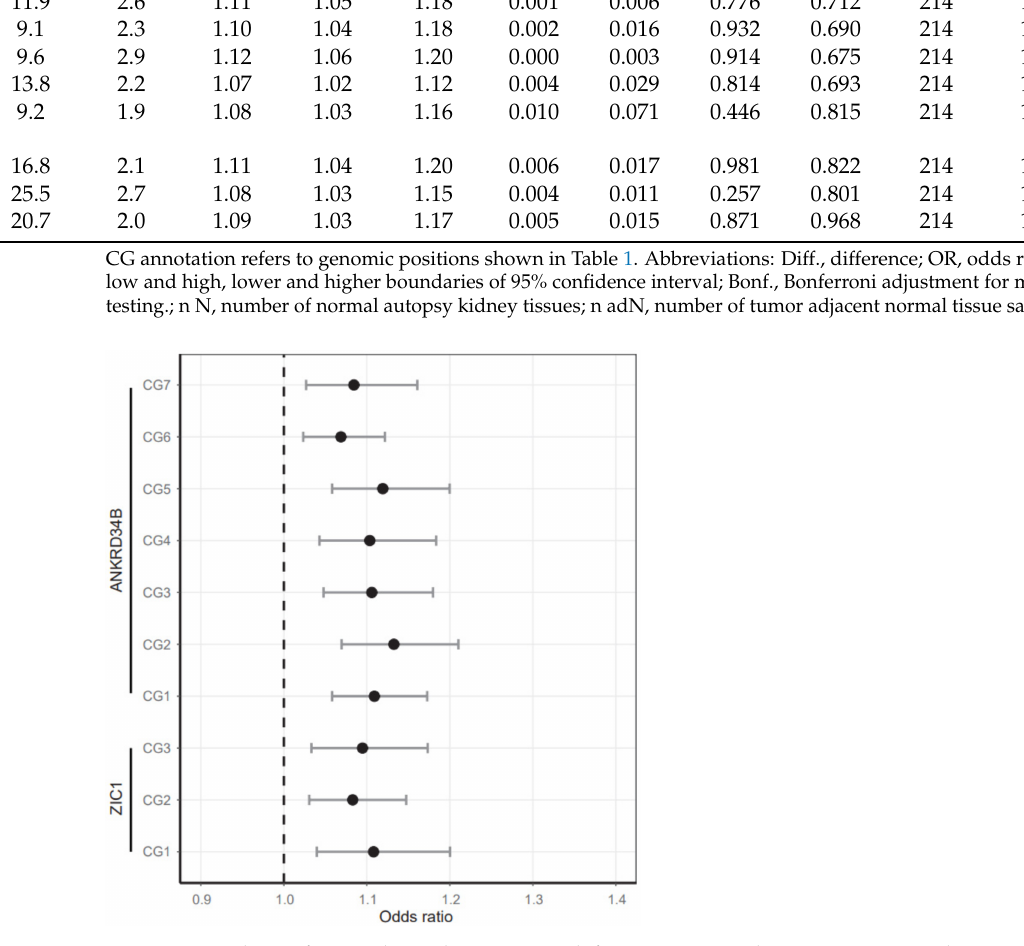
Figure 4. Analysis of age-independent tumor risk for CG1-CG7 and CG1-CG3 sites in the ANKRD34B and ZIC1 candidate gene. OR (black filled circles) and 95% confidence intervals and the no risk OR = 1 line (dashed line) are presented. Corresponding p -values of logistic regression and covariate parameters of analyses are shown in Table